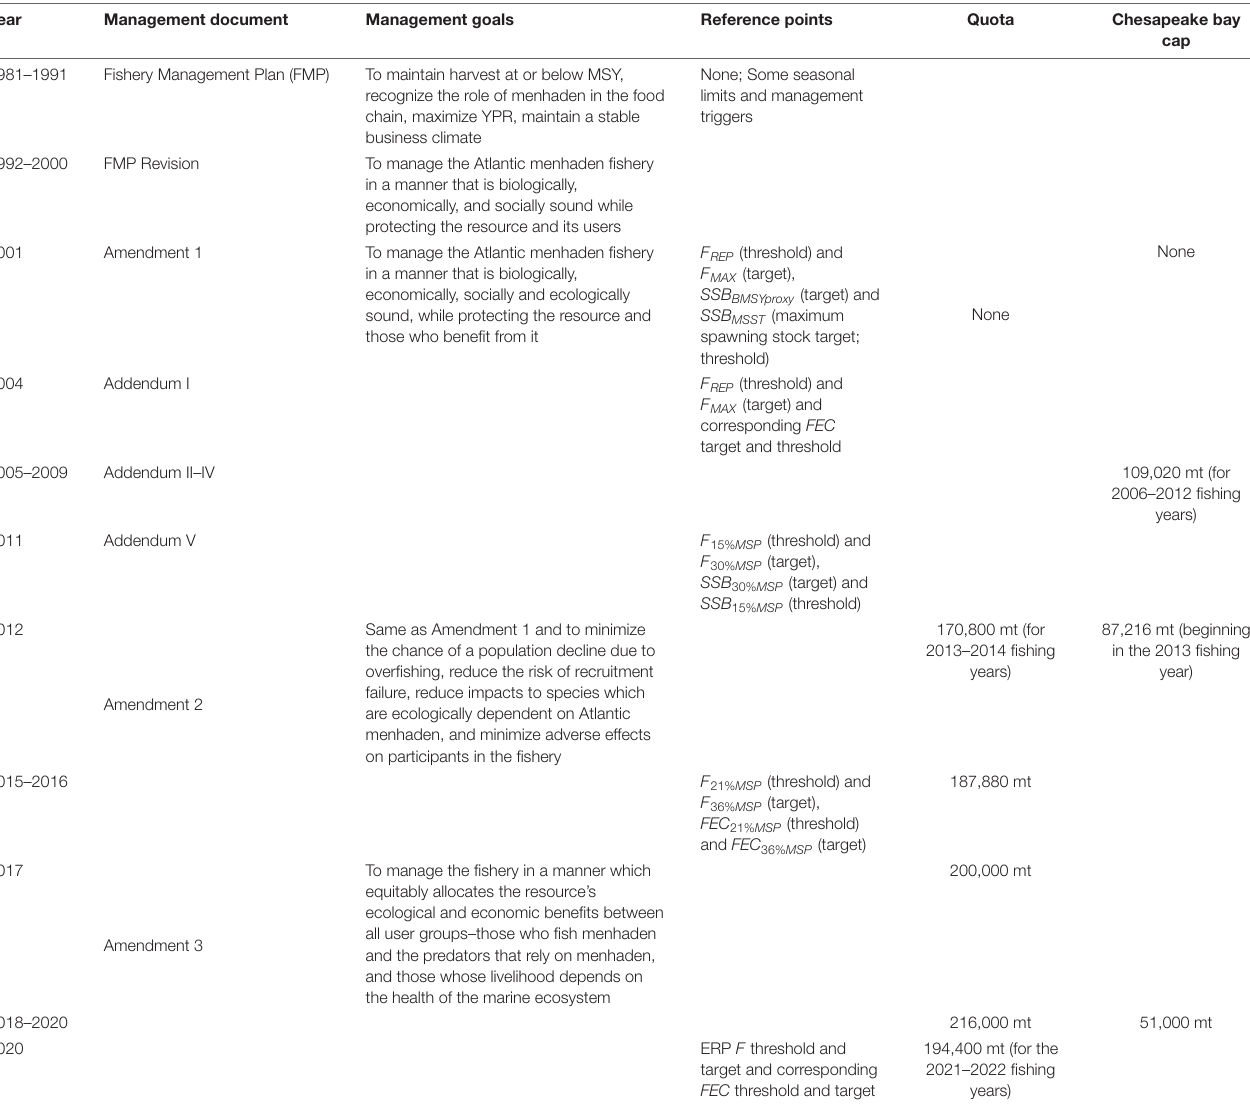
TABLE 1 | Key management documents, objectives, reference points, United States coastwide quota levels, and harvest caps on Atlantic menhaden for